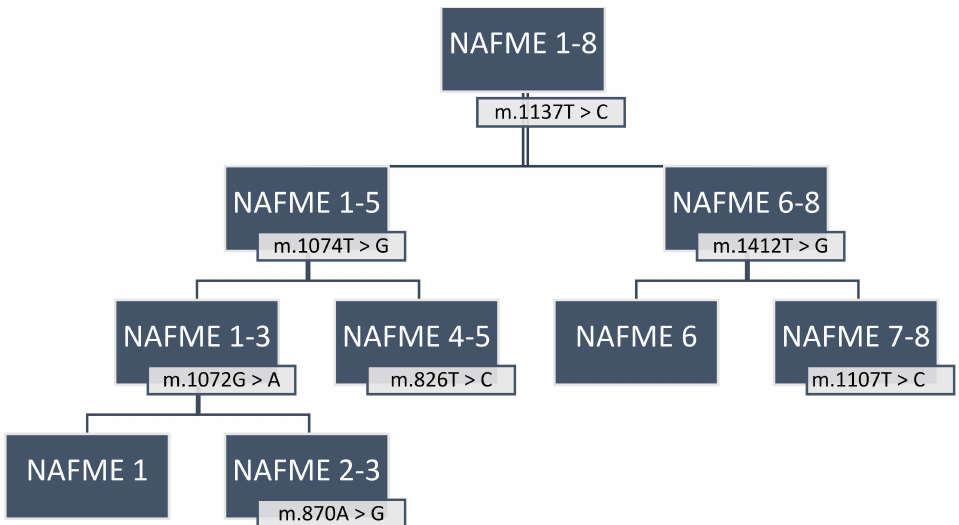
Figure 5. Flowchart to identify haplotypes of the Bemisia tabaci B mitotype using the newly characterized signature SNPs. NAFME (North Africa—Middle East) 1–8 are biogeographic designations of the B . tabaci B haplotype groups delineated in this